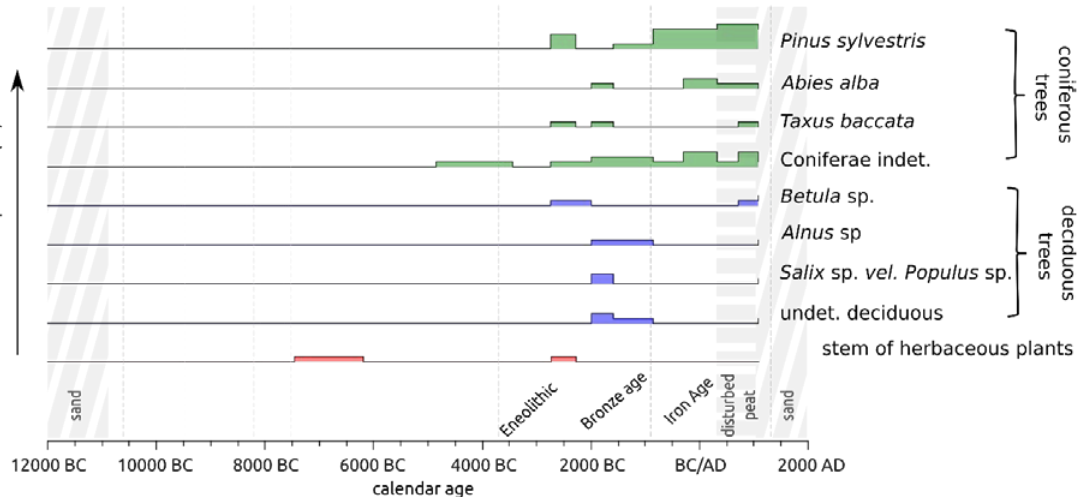
Figure 6. Results of charcoal taxonomical identification plotted on a calendar time scale.